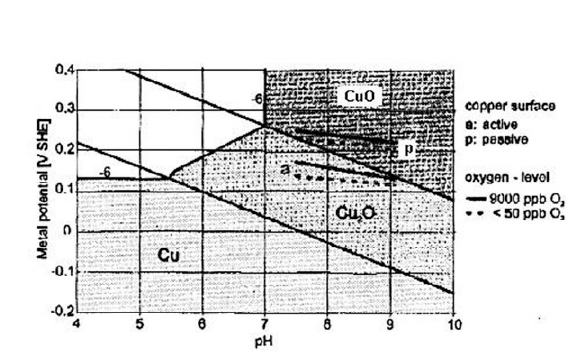
Figure 3: Pourbaix diagram for copper.